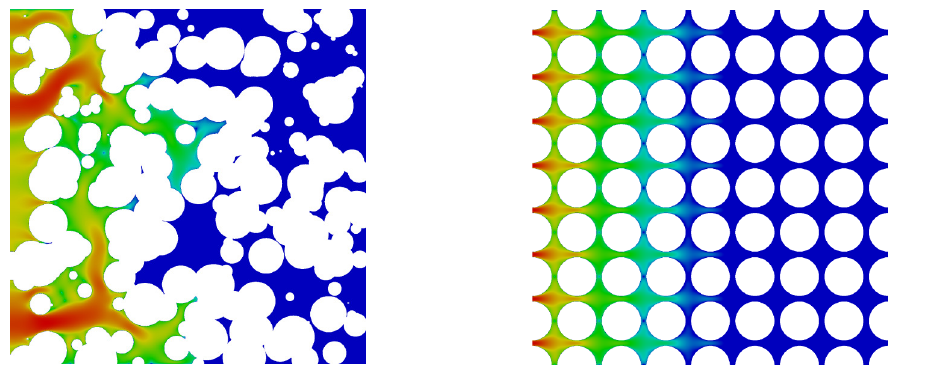
Figure 7. Examples of sparse geometries with 4096 2 nodes and porosity φ = 0.4. Pressure boundary conditions were set on the inlet ( left wall, ρ = 1.016) and outlet ( right wall, ρ = 1.0), bounce back on the top and bottom walls and on borders of obstacles, viscosity ν = 0.5. Colours correspond to the velocity magnitude after 10 6 time steps; a logarithmic scale is used. Calculations took about half an hour per